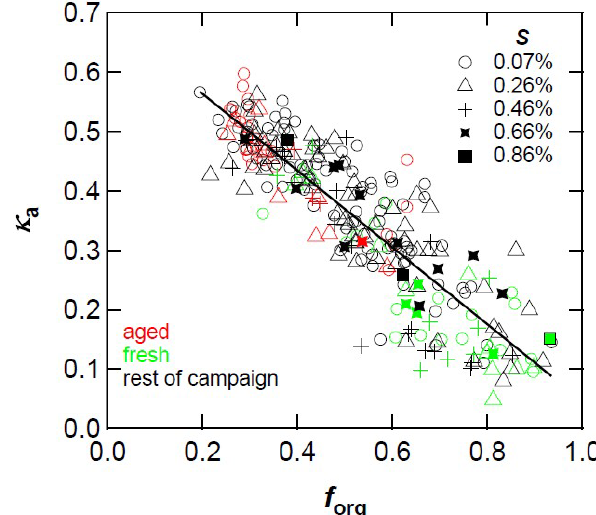
Figure 6. Dependence of κ a on mass fractions of organics for three periods over the campaign (red: the aged regional pollution period; green: the fresh city pollution period; black: the rest of the cam- paign). Reprint with permission by Gunthe et al.